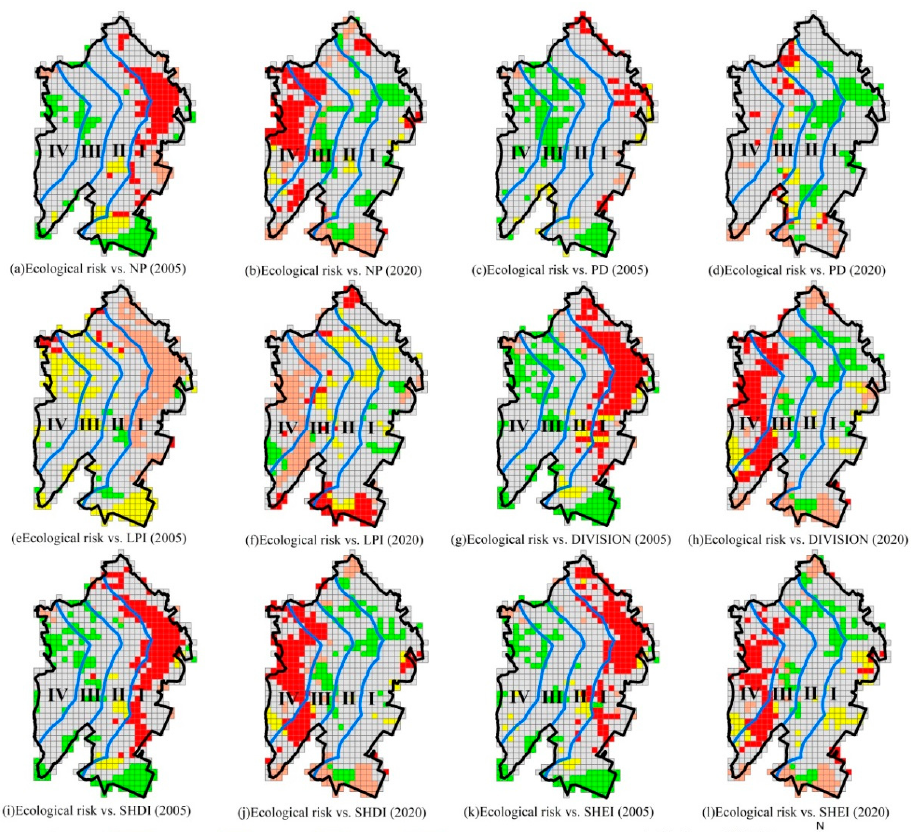
Figure 9. LISA cluster map between ecological risk and landscape metrics in 2005 and 2020. (Gra- dient I (0–2 km), gradient II (2–4 km), gradient III (4–6 km) and gradient IV (>6 km) from the coastline to the inland).